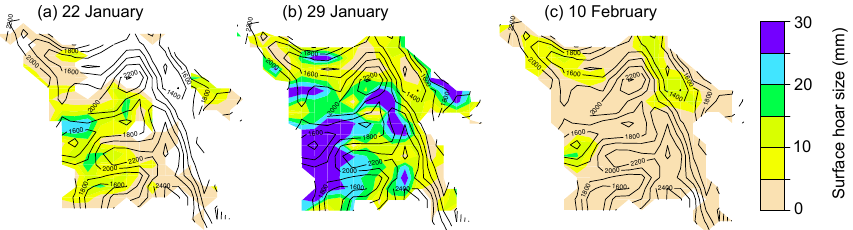
Figure 6. Modelled surface hoar sizes at High-Resolution Deterministic Prediction System (HRDPS) grid points in Glacier National Park on (a) 22 January, (b) 29 January, and (c) 10 February. Black contour lines show the topography of Glacier National Park resolved by the model.